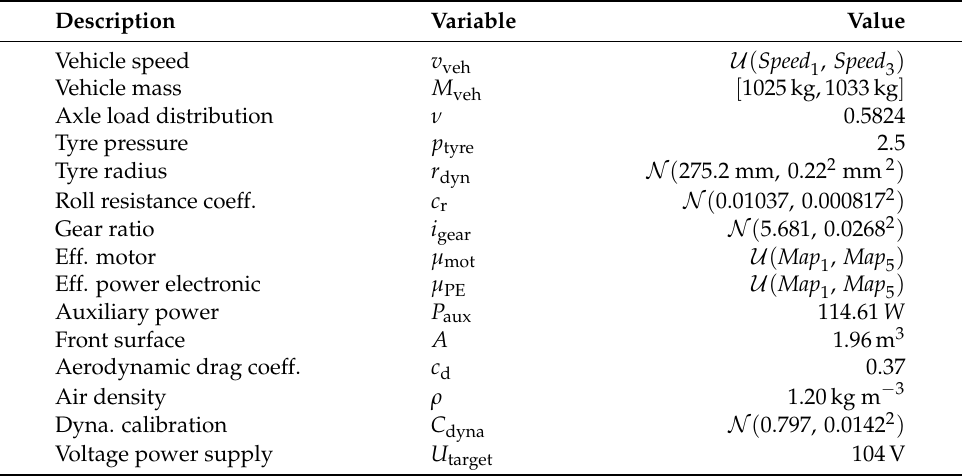
Table 1. Model parameters θ v = ( θ v θ v r = [ M veh c d p tyre ] . Their uncertainties are